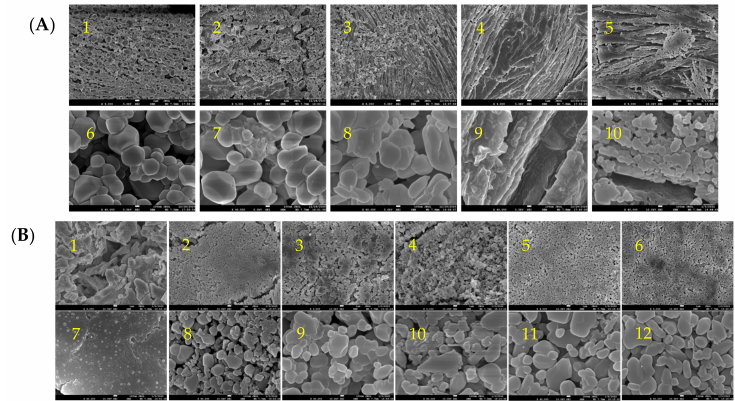
Figure 1. Microstructure of myofibrillar protein particles under scanning electron microscope: ( A ) mi- crostructures at different pH (0.6 M NaCl; A1—pH 3.0, A2—pH 5.0, A3—pH 7.0, A4—pH 9.0, and A5—pH 11.0 at 4000 × magnification; A6—pH 3.0, A7—pH 5.0, A8—pH 7.0, A9—pH 9.0, and A10—pH 11.0 at 40,000 × magnification); ( B ) microstructures under different Na concentrations (pH = 7; B1—0 M, B2—0.20 M, B3—0.40 M, B4—0.60 M, B5—0.80 M, and B6—1.0 M at 4000 × magnification; B7—0 M, B8—0.20 M, B9—0.40 M, B10—0.60 M, B 11—0.80 M, and B 12—1.0 M at 40,000 ×